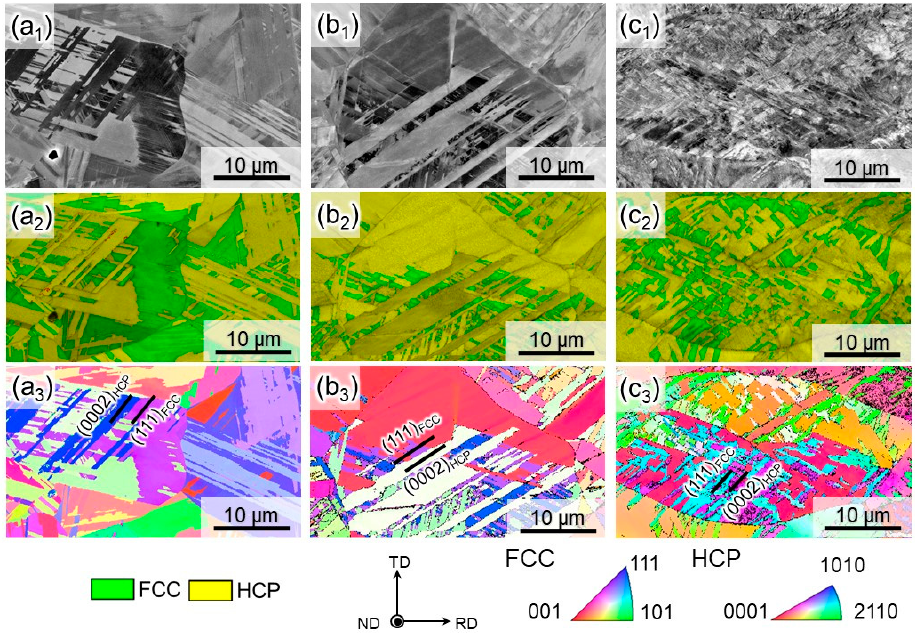
Figure 5. ECCI images, phase map, and ND-IPF maps of the ( a 1 – a 3 ) as-solution-treated, ( b 1 – b 3 ) low-temperature-annealed, and ( c 1 – c 3 ) ausformed specimens. The black lines in ( c 1 – c 3 ) indicate examples of traces along the (111) FCC or (0002) HCP planes.